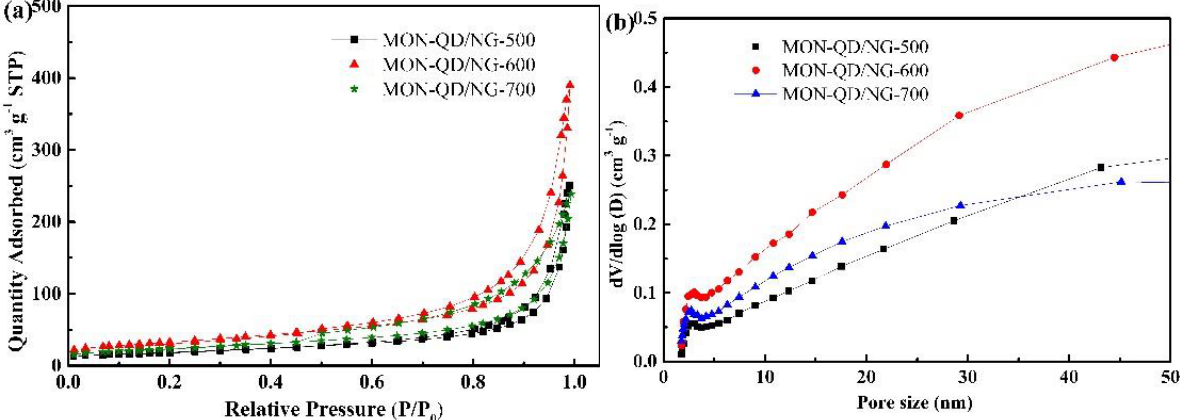
Figure 5. BET tests: ( a ) The adsorption and desorption isothermal curves of three MON-QD/NG composite materials; ( b ) pore size distribution.